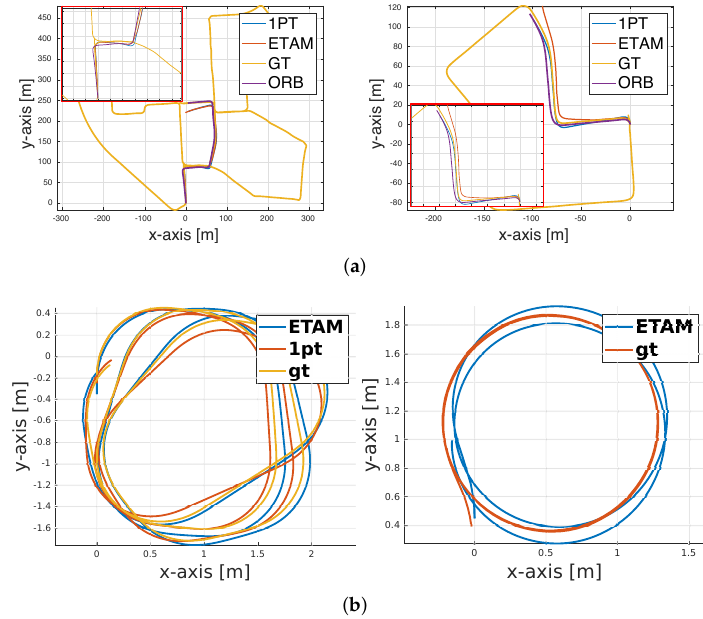
Figure 6. Results for both our method and 1pt-RANSAC on long outdoor trajectories ( top ) and indoor sequences ( bottom ). The indoor sequences are captured under normal ( left ) or challeng- ing illumination conditions ( right ). ( a ) synthetically generated outdoor sequences. ( b ) real data indoor sequences.